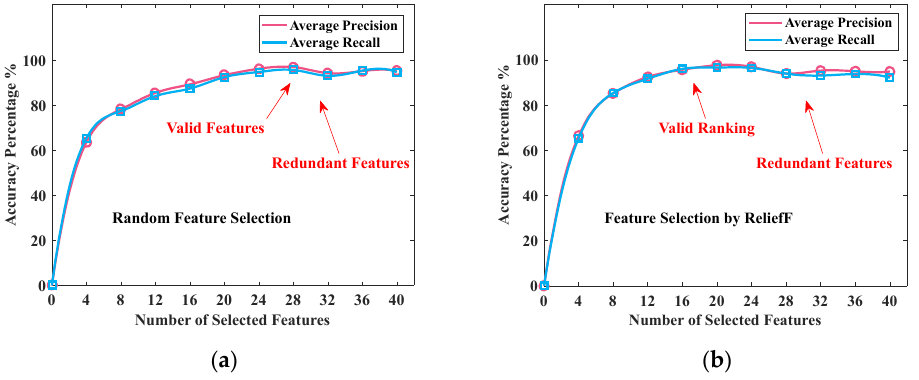
Figure 13. Recognition accuracy under different selected features. ( a ) Training result by random selection; ( b ) Training result by ReliefF selection.